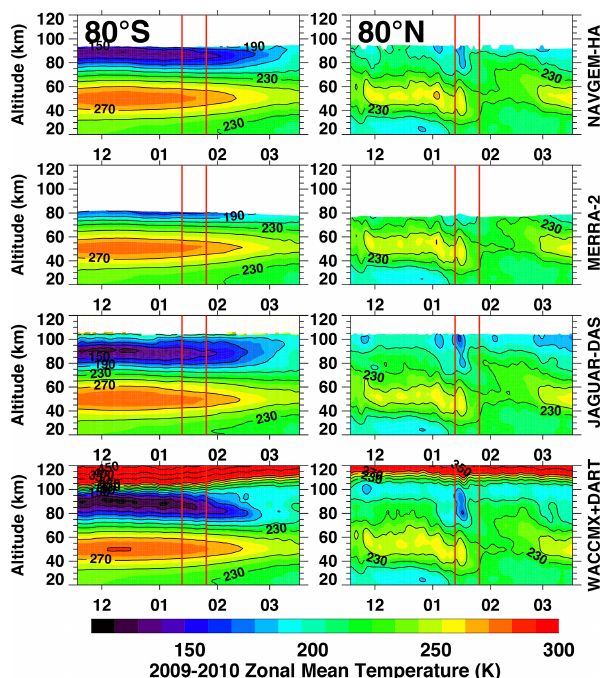
Figure 5. Altitude–time cross-sections from 1 December 2009 to 31 March 2010 of daily mean zonal mean tem- perature in NAVGEM-HA, MERRA-2, JAGUAR-DAS, and WACCMX + DART at 80 ◦ S (left column) and 80 ◦ N (right col- umn). Vertical red lines in each panel denote 27 January (the onset of sustained easterly flow in the mesosphere) and 9 February (the onset of easterly flow in the stratosphere), as described in the text. Month tick labels along the x axes are placed at the 15th of each